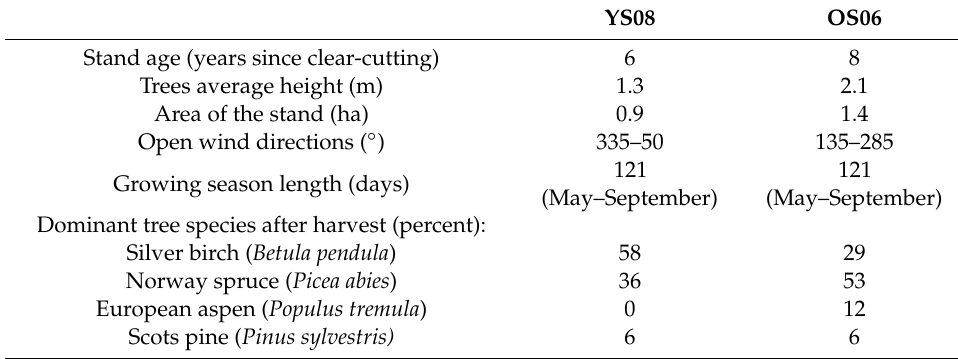
Table 1. Characteristics of the stands at the Järvselja Training and Experimental Forest Centre, Estonia. YS08 OS06 Stand age (years since clear-cutting)